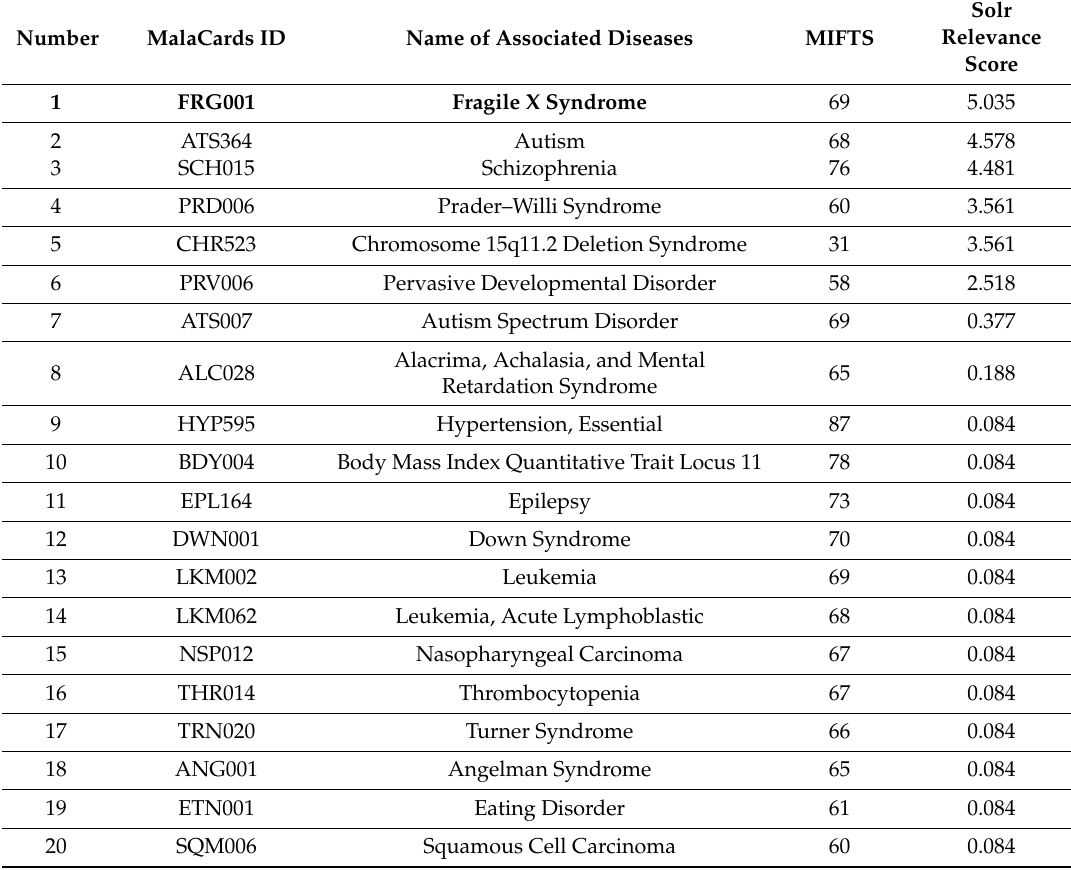
Table 10. Putative Associated Diseases for CYFIP1